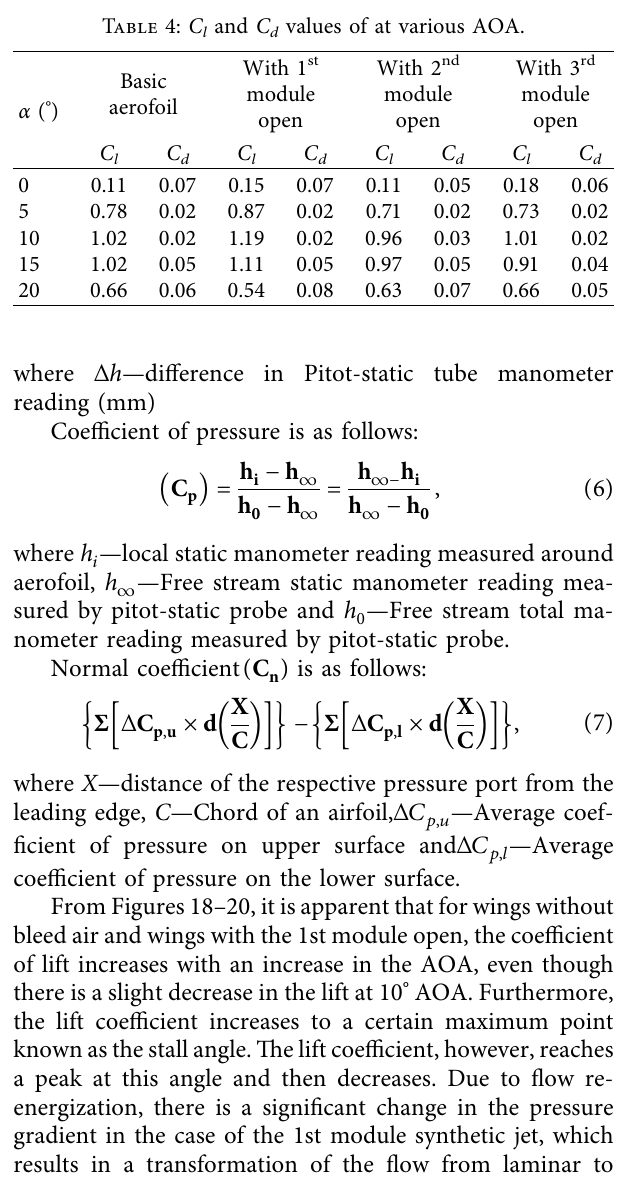
d and angle of attack.